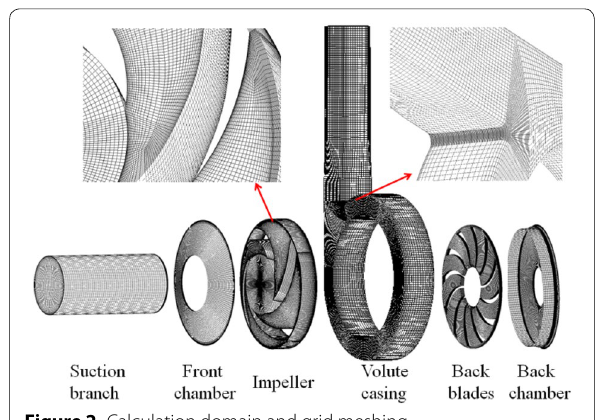
Figure 2 Calculation domain and grid meshing